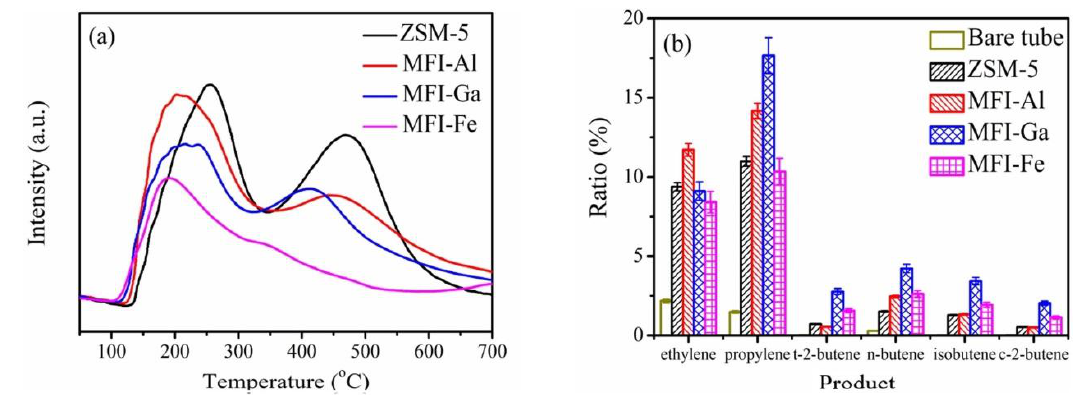
Figure 18. NH 3 -TPD profiles of the isomorphous MFI nanosheet zeolites ( a ) and light alkenes selectivity ( b ) of n -dodecane cracking at 550 °C under 4 MPa [44]. Copyright Elsevier, 2017.